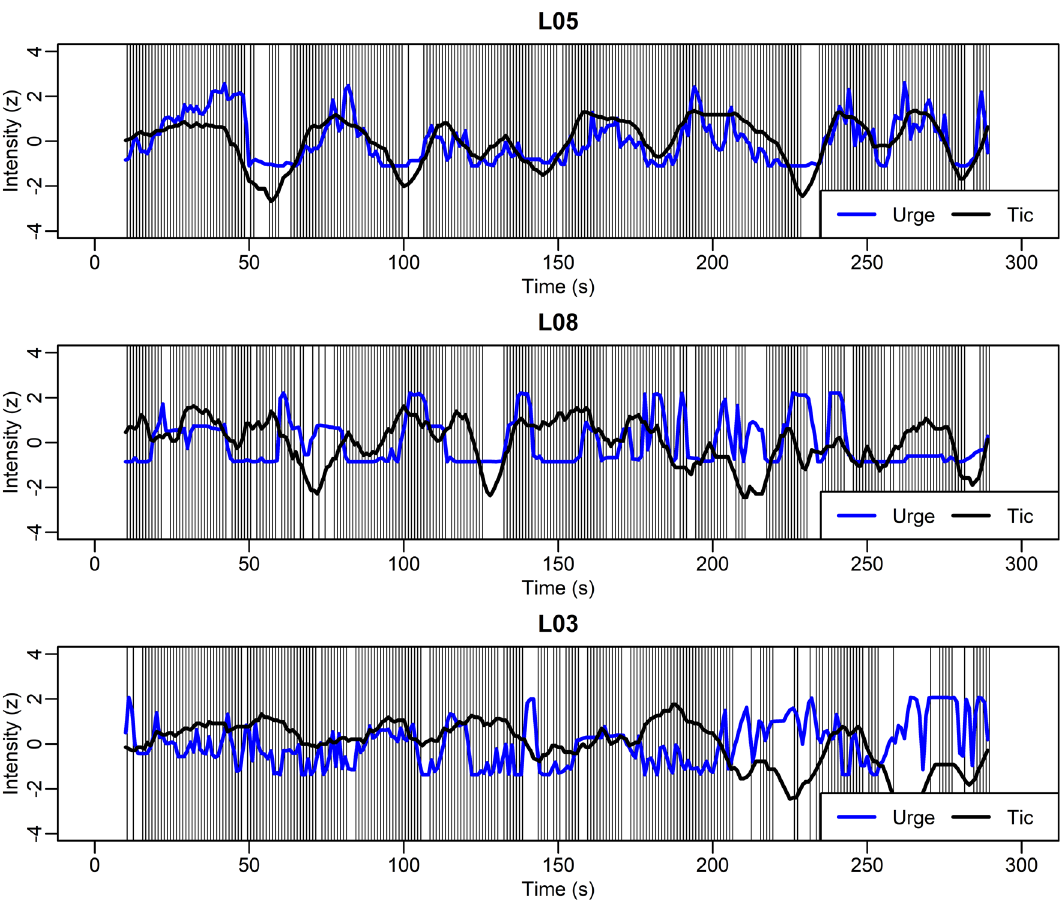
Figure 2. Individual urge-tic time series from three different patients, one with a clearly positive urge-tic association (L05, upper panel), one with no systematic association (L08, middle panel), and one with a negative urge-tic association (L03, lower panel). The plots show subjective urge (blue line), instantaneous tic intensity (black line, central moving average of length 11 s) and times of tics (vertical light-gray